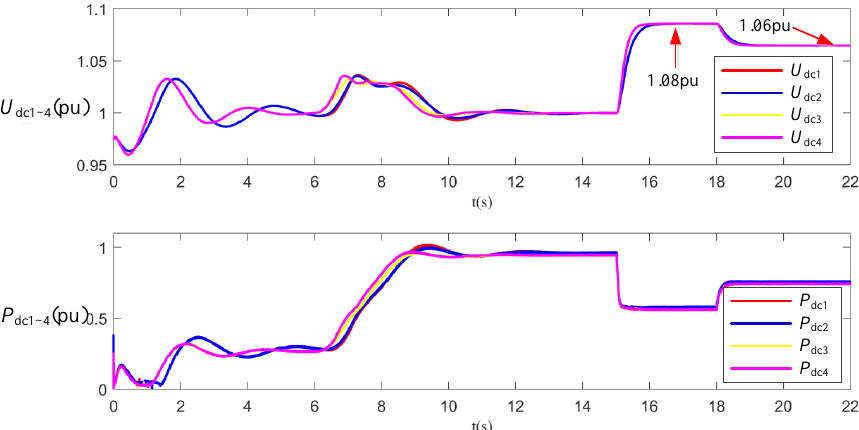
Figure 14. DC voltage and power of isolated DC/DC converter 1~4.